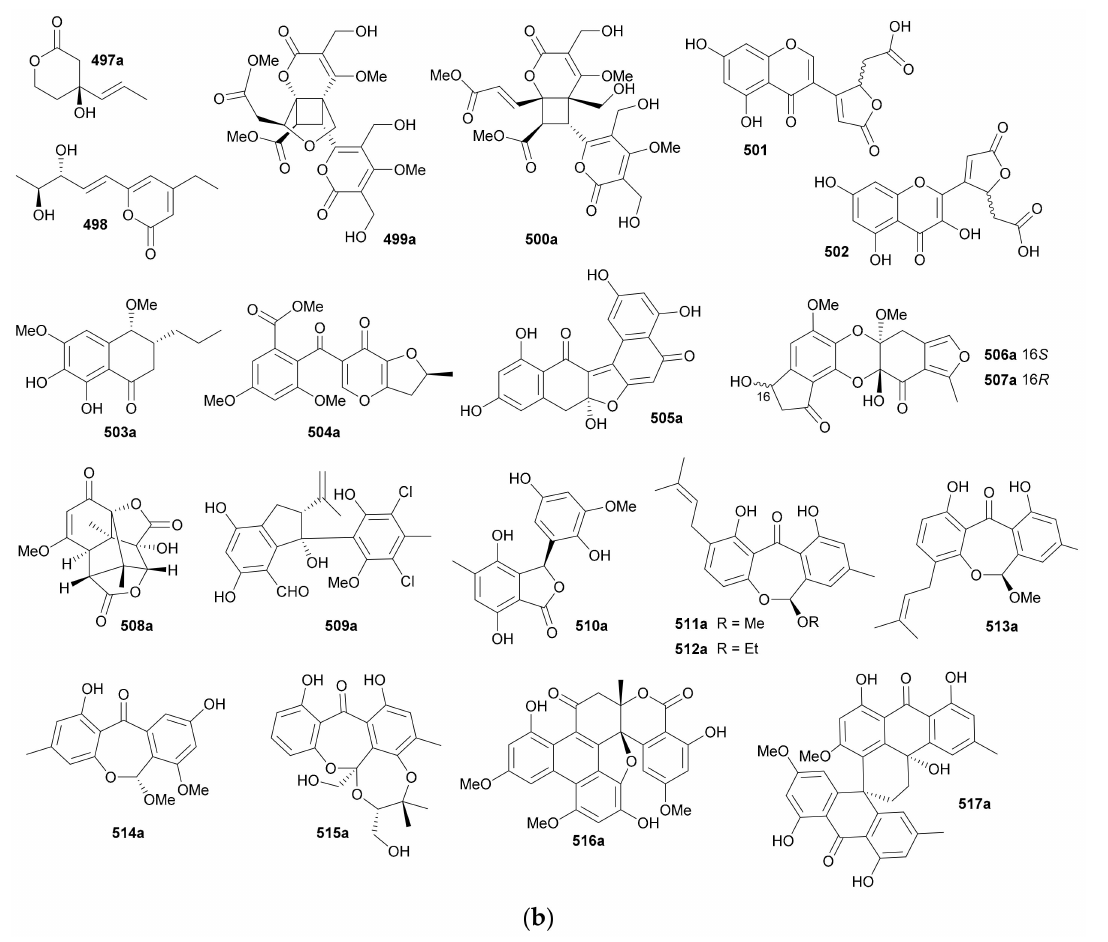
Figure 29. ( a ) Structures of nonalkaloids from phylum Ascomycota (Part 1). ( b ) Structures of nonalkaloids from phylum Ascomycota (Part